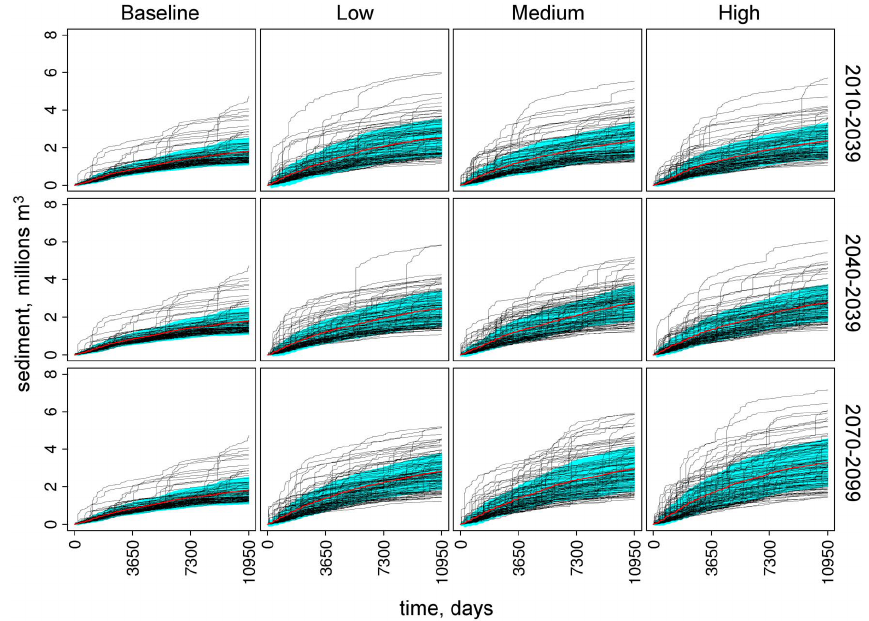
Fig. 3. Cumulative daily sediment outputs for all runs of 2010–2039, 2040–2069 and 2070–2099 (vertically) periods for the Low, Medium and High emissions scenarios (horizontally). Daily mean cumulative sediment is plotted as a red line, and daily standard deviation as cyan shading. For each time slice, the baseline climate, 1961–1990, results are plotted in the first panel for comparison.